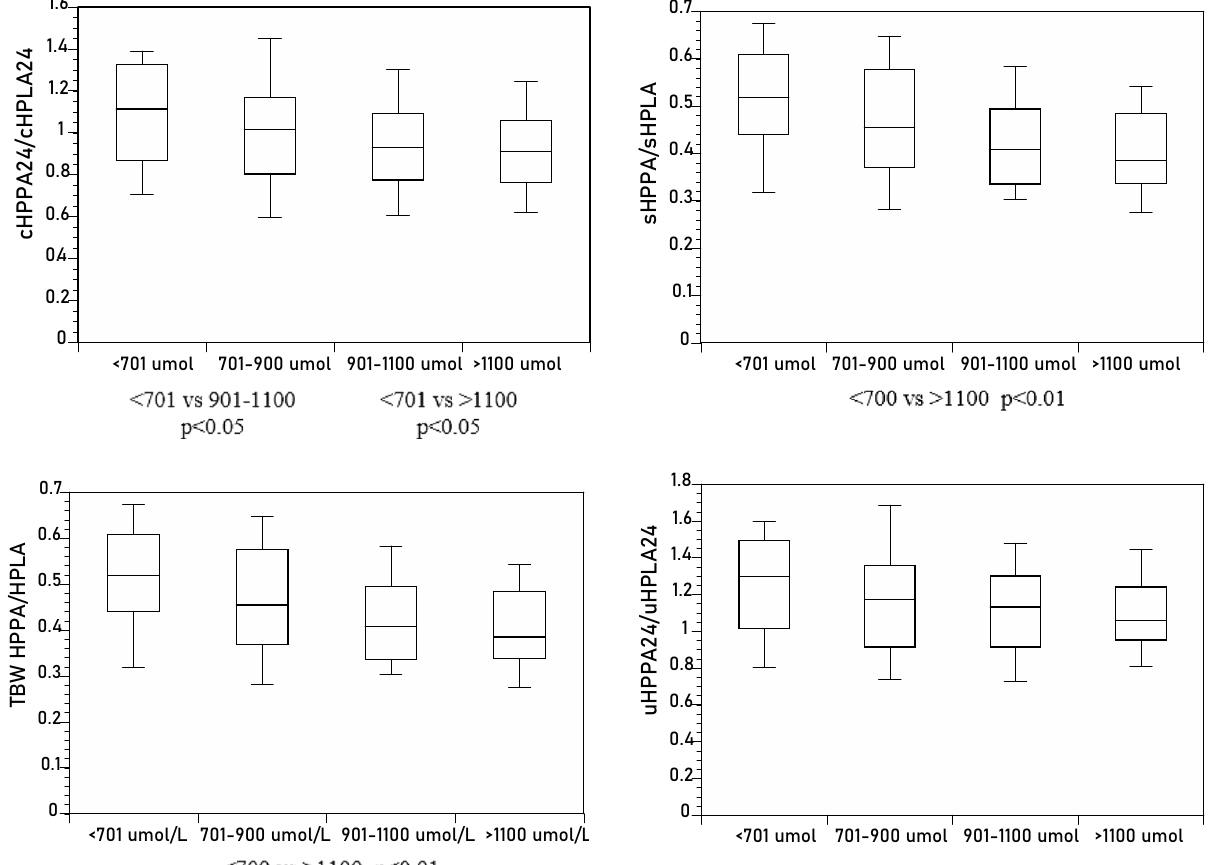
Figure 4. Differences in sHPPA/sHPLA, uHPPA 24 /uHPLA 24 , tbwHPPA/tbwHPLA, and cHPPA 24 /cHPLA 24 across the sTYR groups of < 701, 701–900, 901–1100 and > 1100 µmol/L ( p values indicated for within-group comparison where statistical significance was